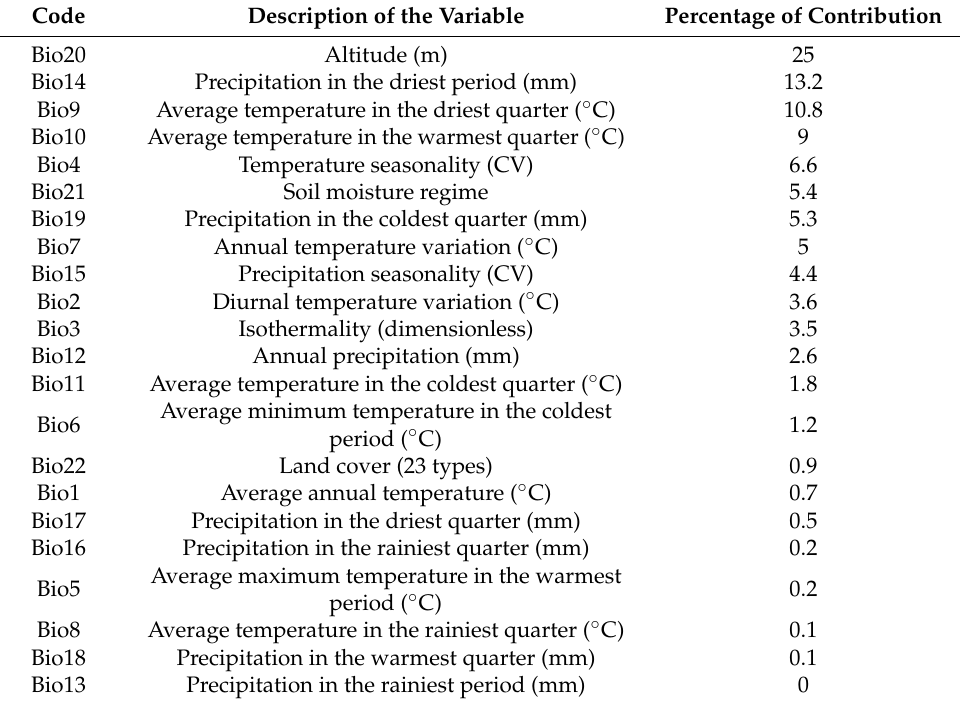
Table 1. Environmental variables used for modeling the potential distribution of Cuphea aequipetala Cav. and its percentage of contribution according to the Jackknife analysis of the importance of the